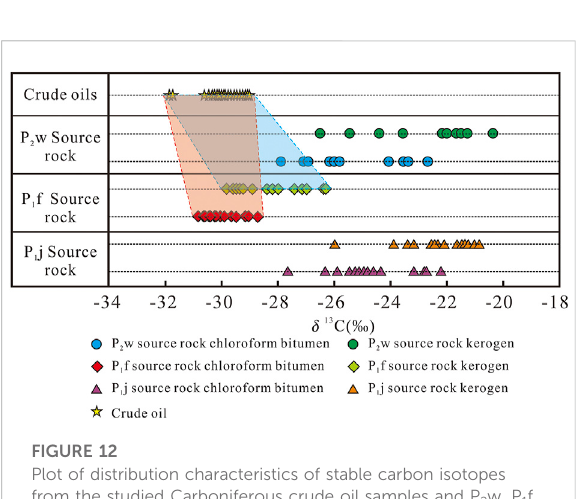
FIGURE 12 Plot of distribution characteristics of stable carbon